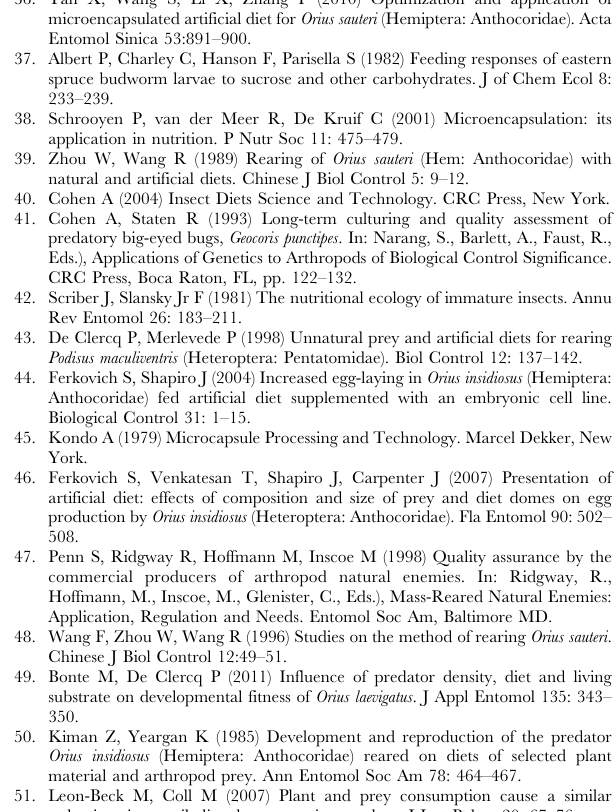
based on life table characteristics. Environ Ecol 41: 30–39. 64. van Lenteren J (2012) The state of commercial augmentative biological control: plenty of natural enemies, but a frustrating lack of uptake. Bio Control 57: 1–20. 65. Silva R, Zanuncio J, Serra˜o J, Lima E, Fihueiredo M, et al., (2009) Suitability